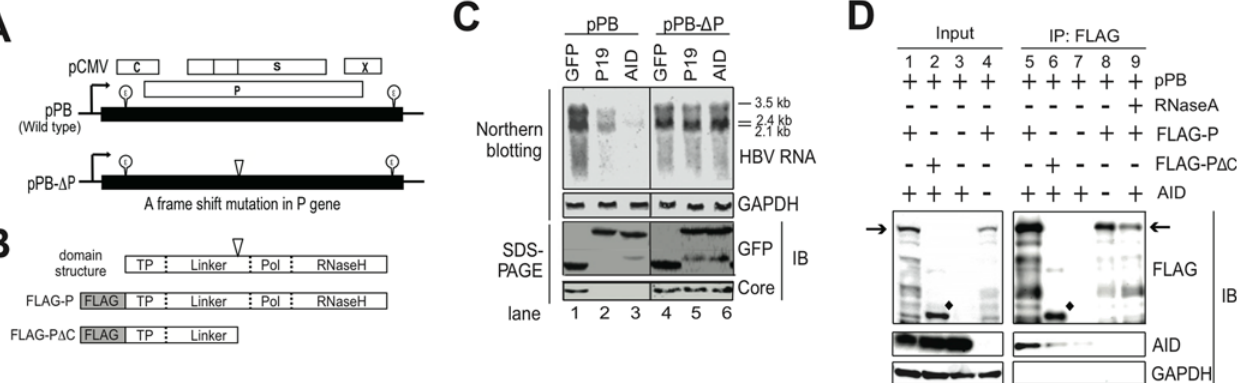
Fig 4. Intact P protein is required for AID-mediated downregulation of HBV transcripts and AID associates with HBV P protein. (A) Schematic diagram of wild-type and mutant HBV replicon plasmids. Partially redundant HBV genomic DNA is shown as black boxes and the positions of 5 0 - ε and 3 0 - ε are shown. Open reading frames corresponding to C, P, S, and X genes are shown as open boxes. The position of the frame-shift mutation in the mutant replicon plasmid (pPB- Δ P) is indicated as an open triangle. This frame-shift mutation results in loss of the C-terminal portion (polymerase and RNase H domains) from the P protein; pCMV, CMV promoter. (B) Schematic diagram of P protein domain structure; (C) Replicon plasmid (pPB or pPB- Δ P) and GFP fusion expression vectors (mock, AID, and p19-mutant AID) were transfected into Huh7 cells, and after four days, AID-mediated downregulation of HBV transcripts was compared between two replicon plasmids or between wild-type and p19 mutant AID using northern blotting. Expression of HBV core and GFP fusion proteins (mock, AID, and p19-mutant AID) was confirmed using SDS-PAGE and western blotting. (D) Wild-type replicon plasmid (pPB) and indicated protein expression vectors (FLAG-P, FLAG-P Δ C, or AID) were transfected into Huh7 cells. Three days later, physical associations between AID and FLAG-P (or FLAG-P Δ C) proteins were determined using immunoprecipitation (IP). In lane 9, crude extract was incubated with RNase A before immunoprecipitation. Positions of FLAG-P and FLAG-P Δ C proteins are indicated by arrows and diamonds, respectively. The structure of FLAG-P Δ C protein is shown in B. Input; crude extract. Data are representative of two to three independent experiments.